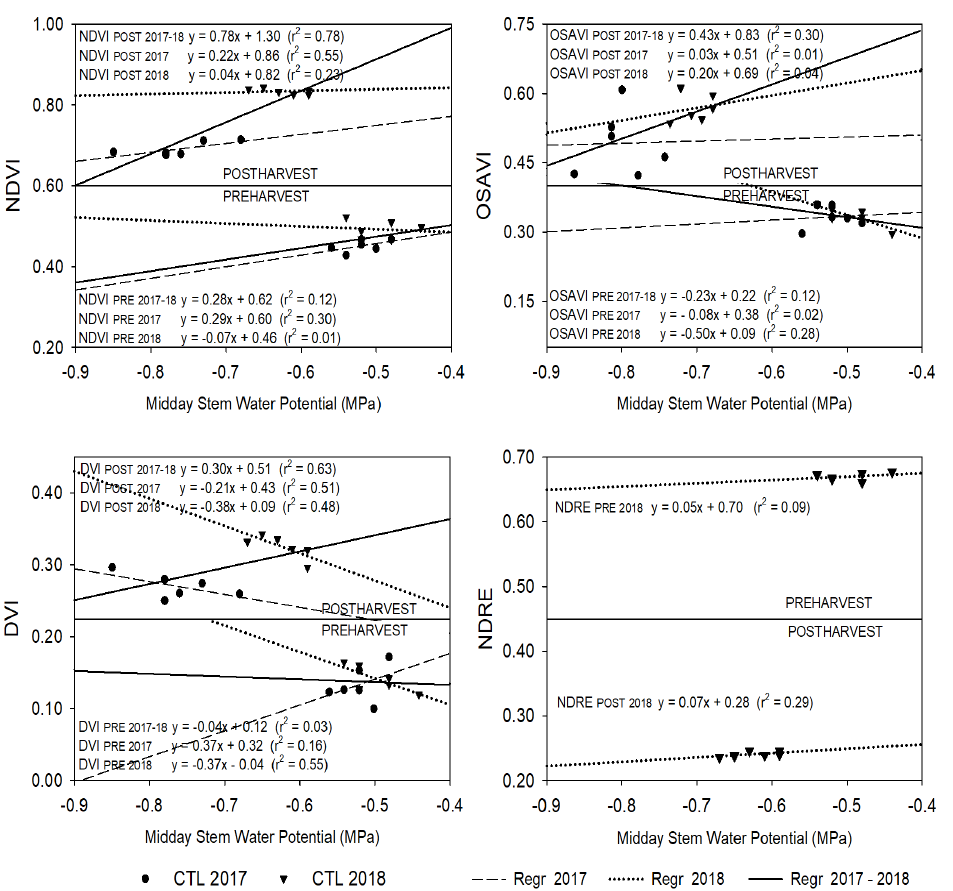
Figure 4. Linear relationships between midday stem water potential and NDVI (normalized difference vegetation index), OSAVI (optimized soil adjusted vegetation index), DVI (difference vegetation index), and NDRE (normalized difference red edge) in CTL trees.